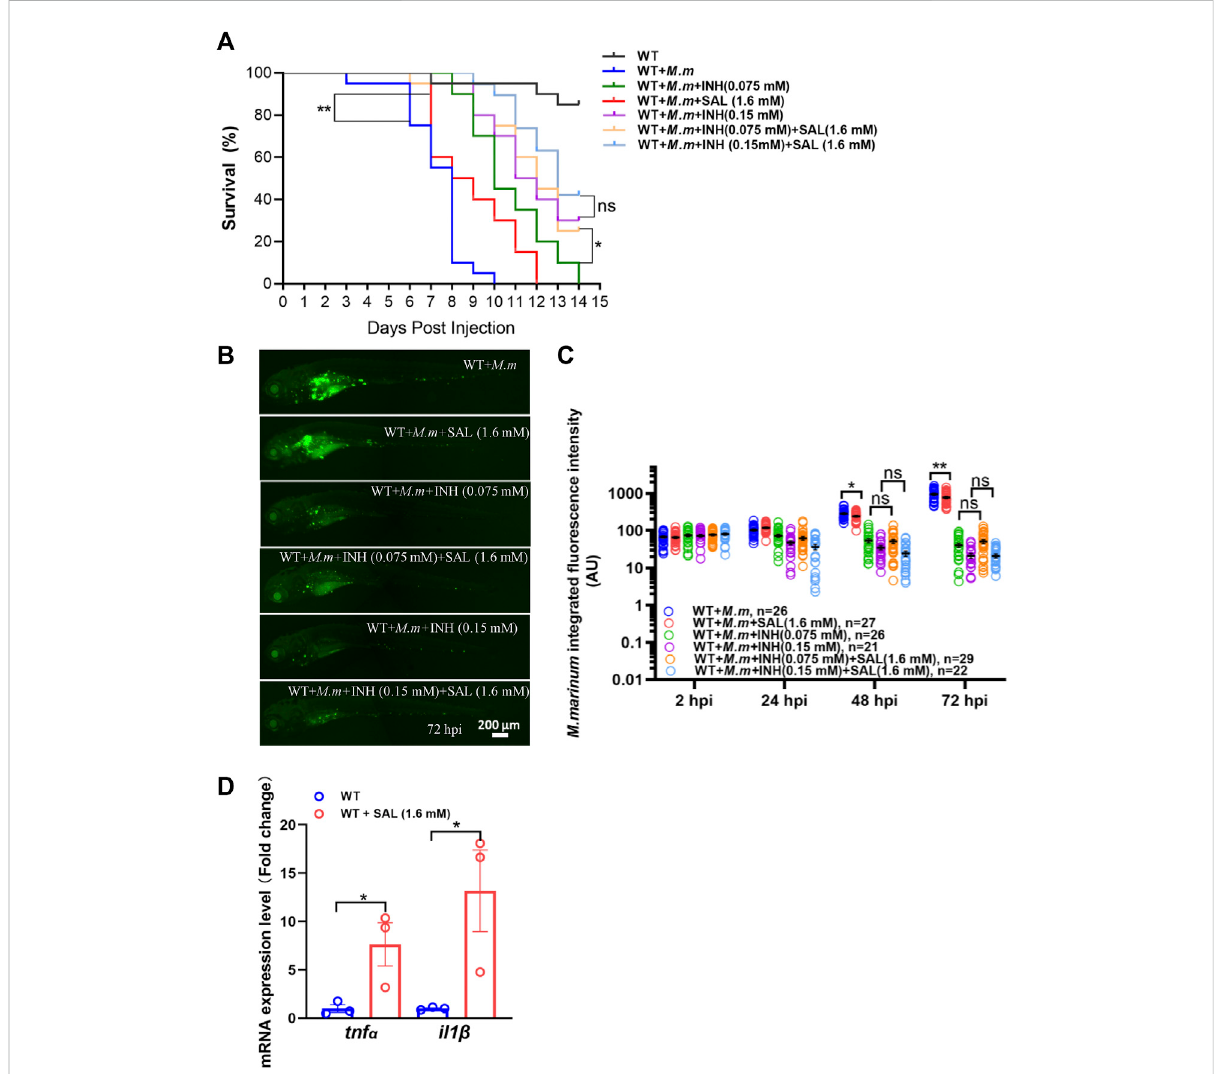
FIGURE 4 Combined treatment of SAL and INH signi fi cantly improve the survival of zebra fi sh during mycobacterial infection. (A) Survival rates of M. marinum -infected zebra fi sh embryos treated with various concentrations of INH and SAL. n = 20 per group. (B) Representative images for the distribution of M. marinum (Wasabi) in different groups of zebra fi sh embryos at 72 hpi. Scale bar: 200 μ m. (C) Statistics of integrated green fl uorescence intensity in (B) . One-way ANOVA was applied for the comparison. (D) Expression of two potent pro-in fl ammatory cytokines at 12 hpi. n = 30 per sample. A and D: data are representative of three independent biological replicates. B and C data are representative of two independent